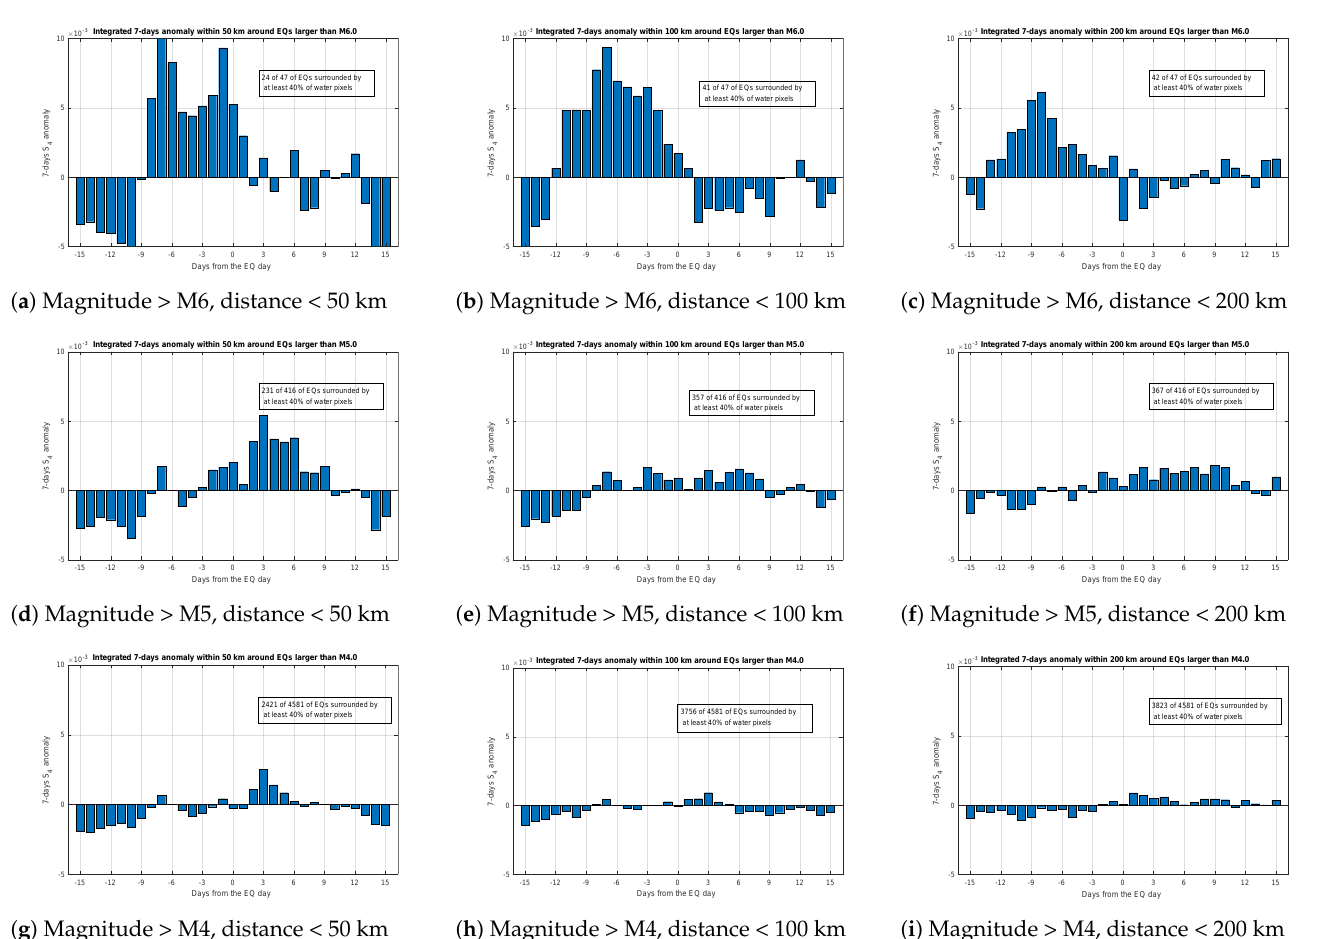
Figure 12. Integrated seven day precursory anomaly within a circle of the indicated radius averaged for all the earthquakes taking place in the period studied, with a magnitude larger than the one indicated in each plot. Only earthquakes surrounded by at least 40% of water are